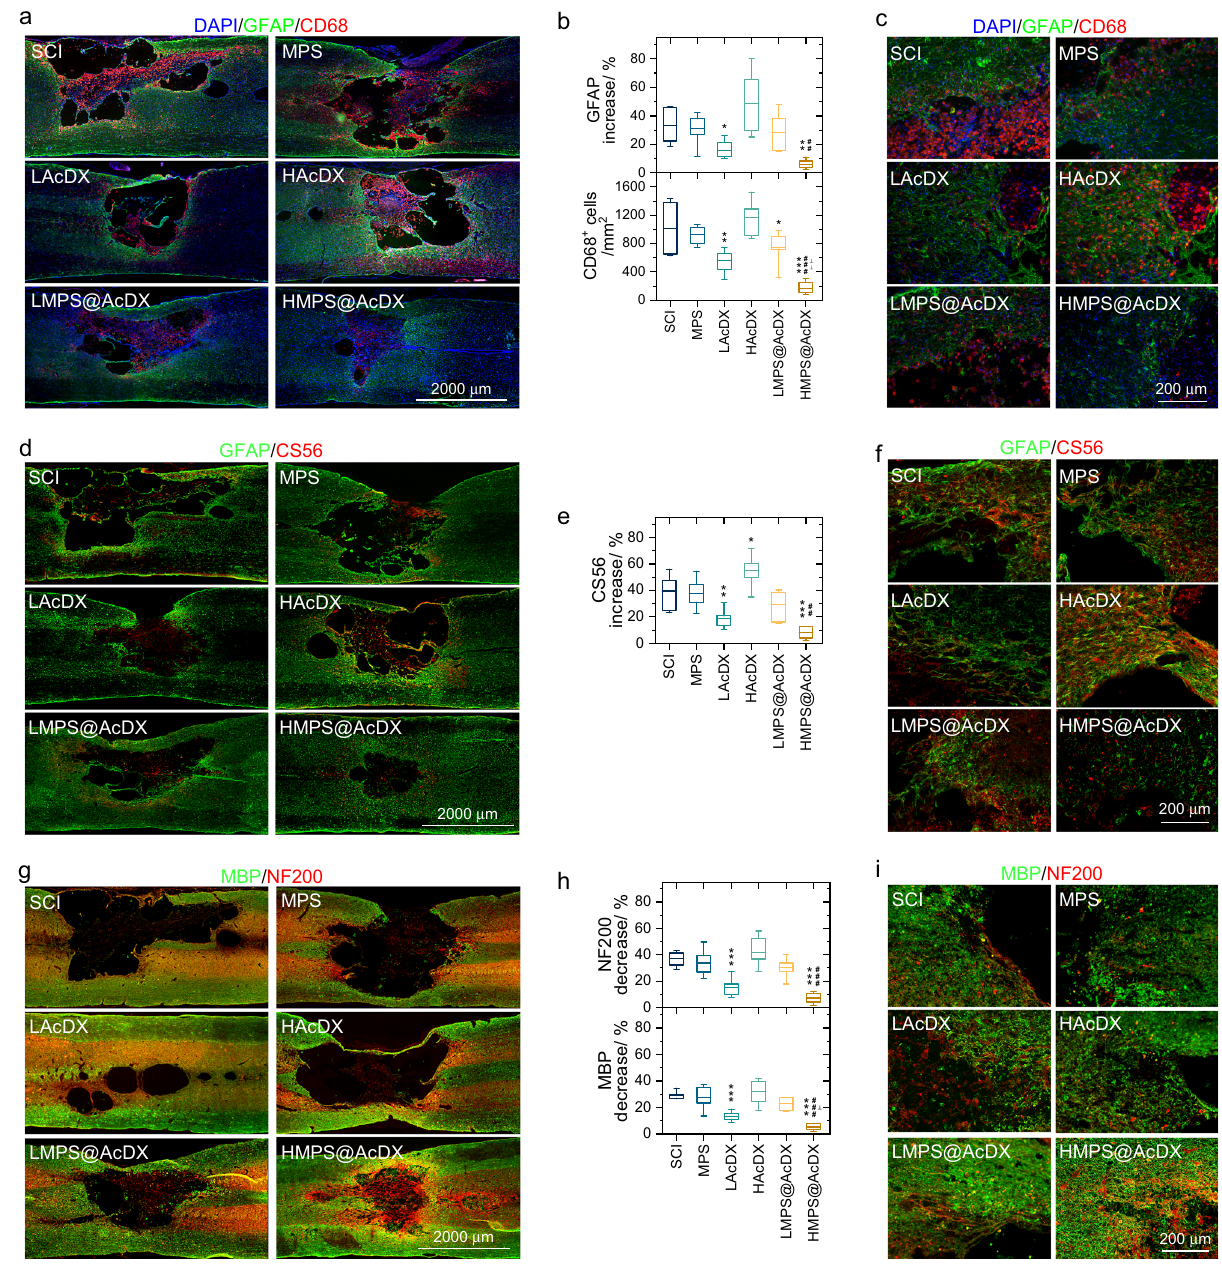
Fig. 6 HMPS@AcDX inhibits gliosis, attenuates the activation of microglia, suppresses CSGP production, and protects axon and myelin sheath. a Representative immunohistochemical staining of GFAP (in green) and CD68 (in red) in longitudinal sections of injured spinal cord at day-28 post injury. The nuclei of all cells were stained with DAPI (in blue). b Semi-quanti fi cation of GFAP intensity and density of microglia in the injured spinal cord. For GFAP intensity, the data are plotted as the relative ratio of the immunoreactivity near the injury site compared with that in distant area. ( n = 6 per group). c Representative immunohistochemical staining of GFAP (in green) and CD68 (in red) adjacent to the lesion area. d The deposition of chondroitin sulfate proteoglycans (CSPGs) determined by CS56 antibody (in red) at day-28 after injury. e Semi-quanti fi cation of CS56 intensity increase in the traumatic lesion area. The data are plotted as the relative ratio of the immunoreactivity near the injury site compared with that in the distant area. ( n = 6 per group). f Enlarged immunohistochemical staining of GFAP (in green) and CS56 (in red) adjacent to the lesion area. g Immunohistochemical staining of MBP (in green) and NF200 (in red) in injured spinal cord at day-28 post trauma. h Semi-quanti fi cation of NF200 and MBP intensity after spinal cord injury therapy. The data are plotted as the relative ratio of the immunoreactivity near the injury site compared with that in distant area. ( n = 6 per group). Box plots show the minimum value, the fi rst quartile, the median, the third quartile, and the maximum value. i Representative immunohistochemical staining of MBP (in green) and NF200 (in red) adjacent to the lesion area. The intervention groups were compared with the SCI group (*); HMPS@AcDX group was compared with the LMPS@AcDX group ( # ) and LAcDX group ( ⊥ ); *, ⊥ P < 0.05, **, ## , ⊥⊥ P < 0.01, ***, ### P < 0.001. Statistical signi fi cance was analyzed using one- way ANOVA followed by Fisher ’ s post-hoc test. Exact P values are given in the Source data fi